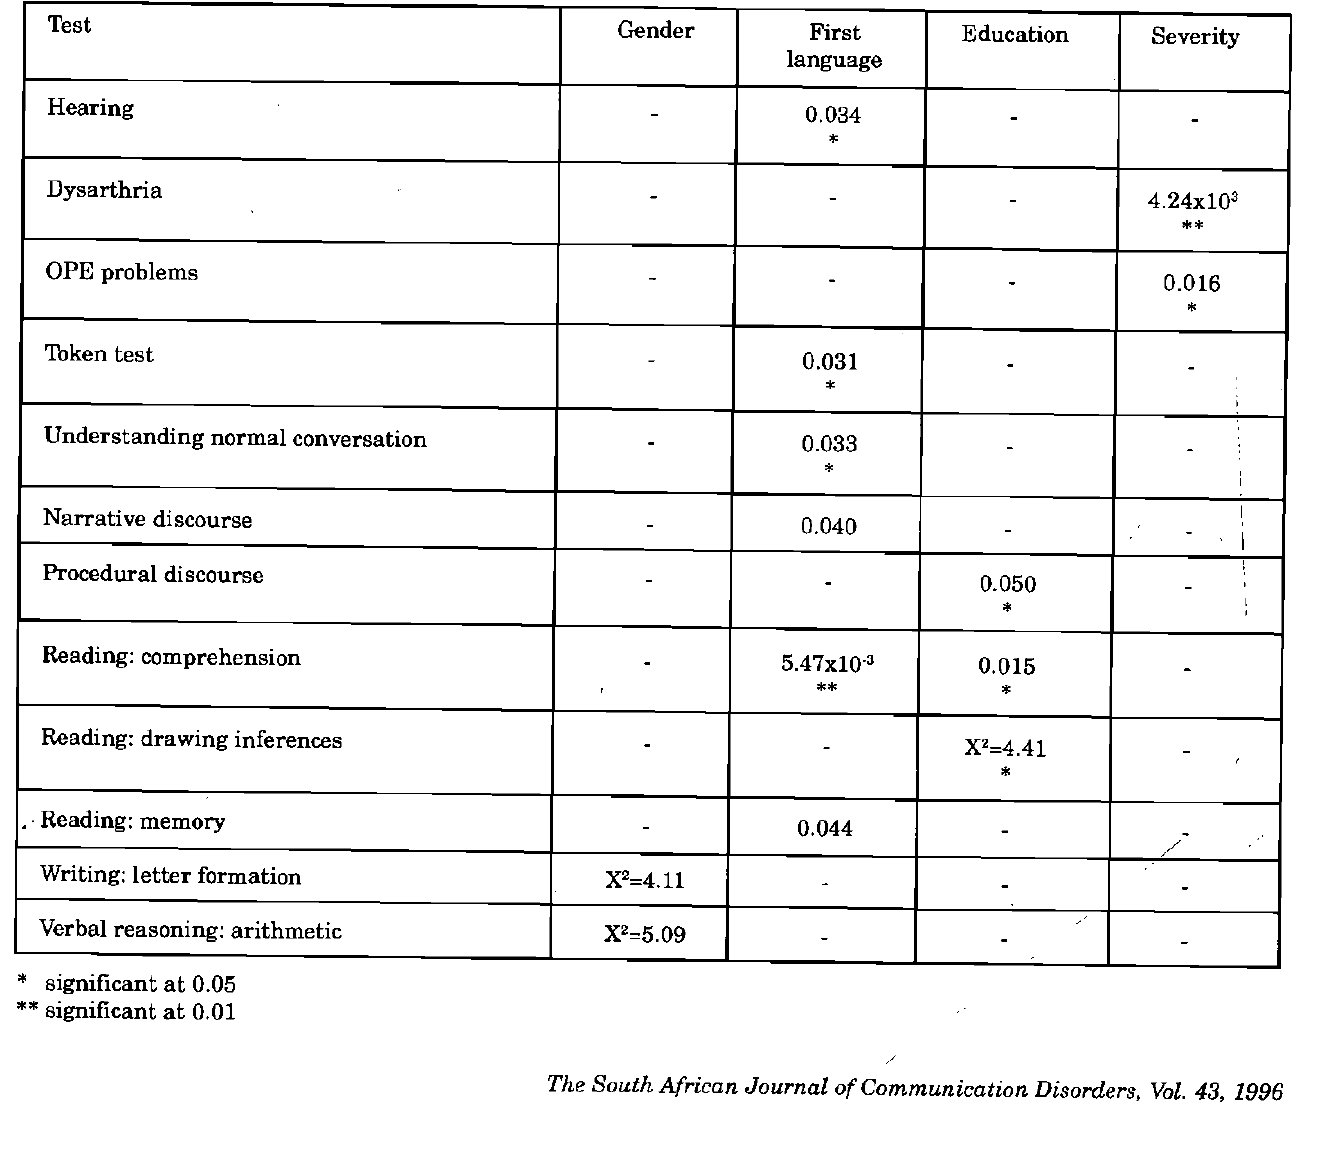
TABLE 3: Significant predictors of communicative outcome (df=l except for severity where df=2)